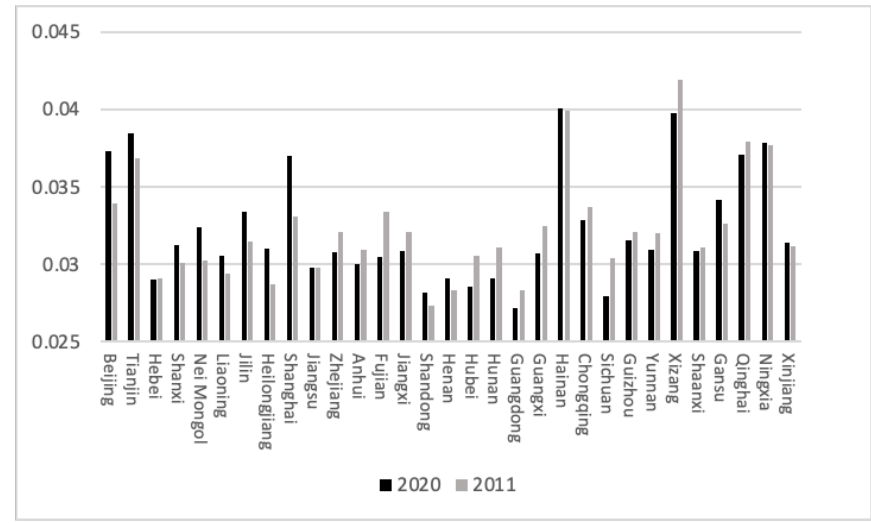
Figure 3. The effectiveness indicators of domestic pollution. (Source: made by the authors).